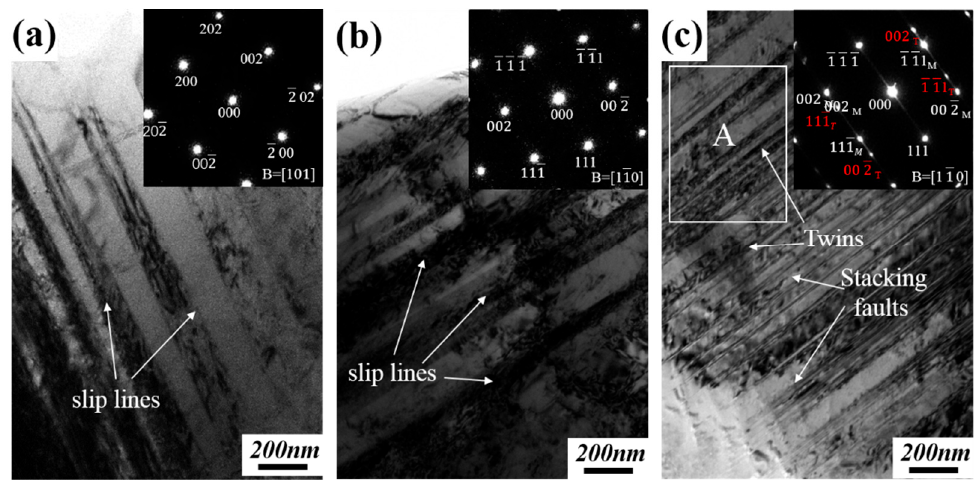
Figure 7. Bright-field transmission electron microscopy images of the semi-solid CuSn10P1 alloy at a strain rate of 10 s − 1 and a temperature of 350 °C with different true strains, inset with selected area electron diffraction (SAED) patterns: ( a ) ε = 0.1, ( b ) ε = 0.2, and ( c ) ε = 0.3.